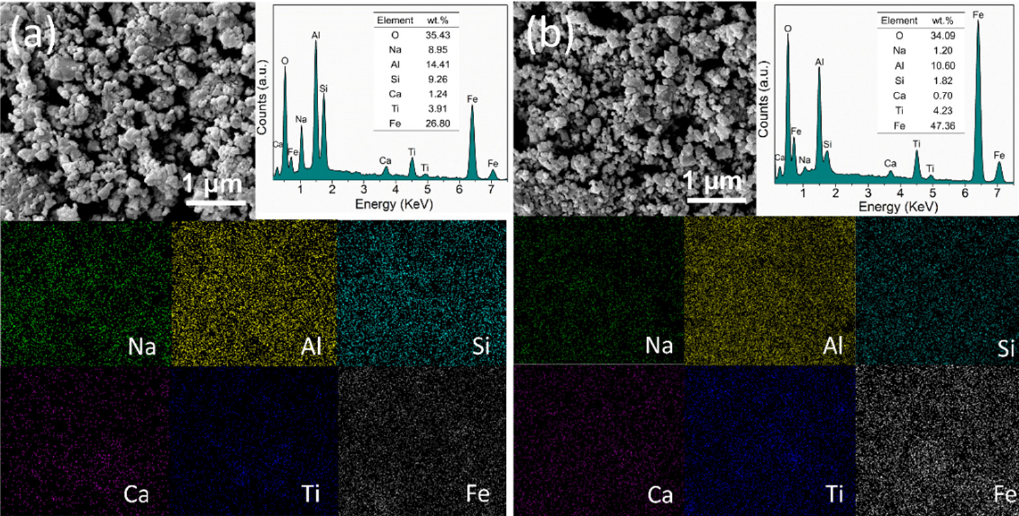
Figure 7. SEM-EDS analysis of RM-800 ( a ) and RM-800A0.1 ( b ). Table 2. The pH of leachate and the relevant weight loss of leached red mud samples. Sample pH of Leachate Mass